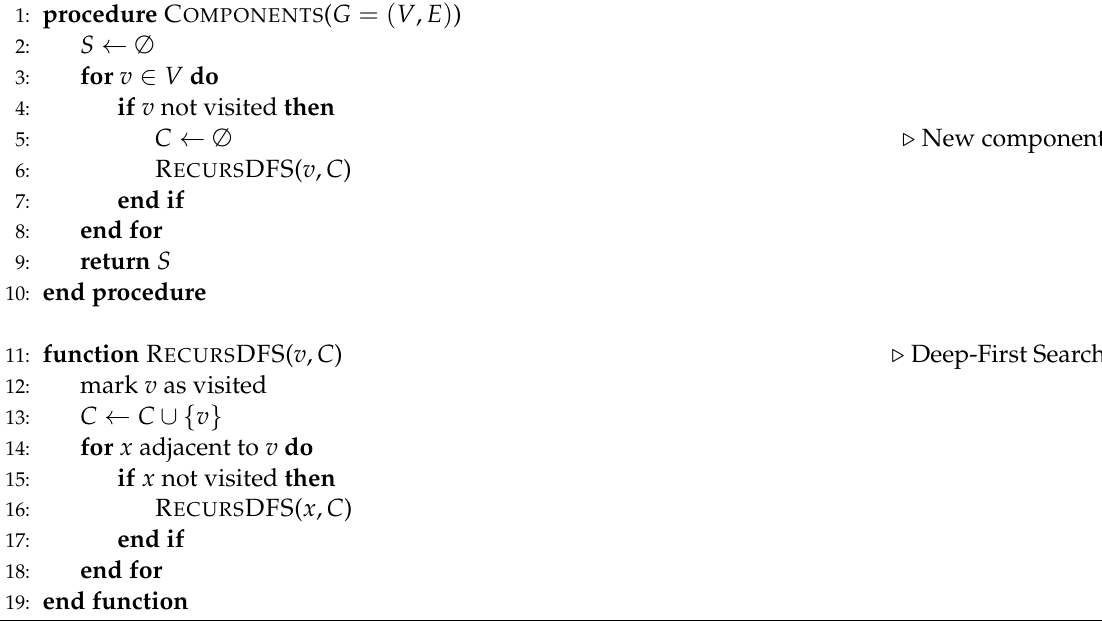
Algorithm 2 Connected components retrieval algorithm for undirected graphs. Requires: G = ( V , E ) , undirected graph. Ensures: S , set of G ’s connected